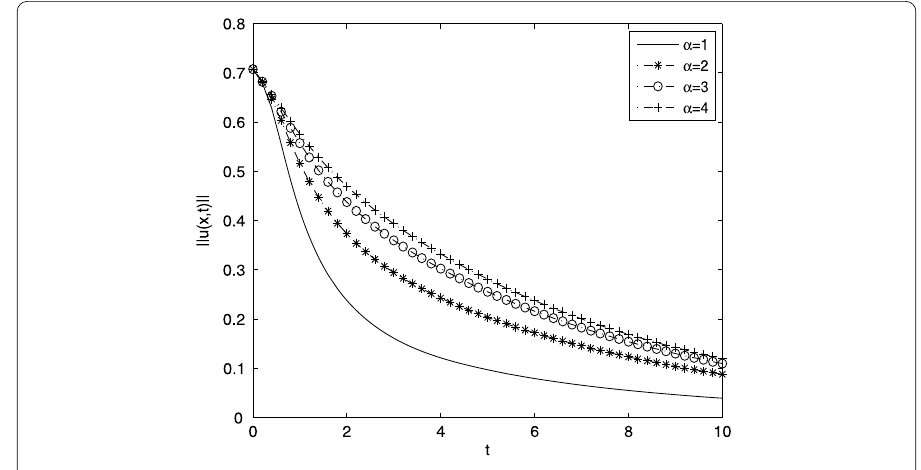
Figure 2 The L 2 -norm of u ( x , t ), (cid:5) u ( x , t ) (cid:5) versus time for different values of α ; σ = 0.01, μ = 0.001, γ 1 = 1, γ 2 = 0.0005, and u 0 ( x ) = sin( π x )